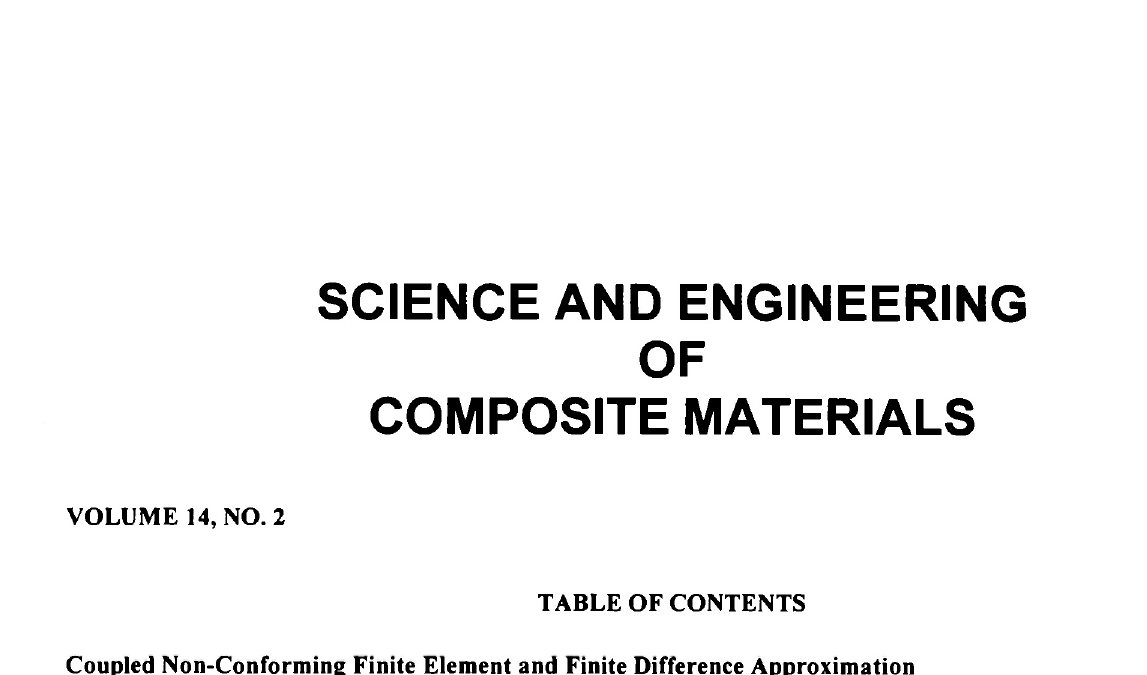
Coupled Non-Conforming Finite Element and Finite Difference